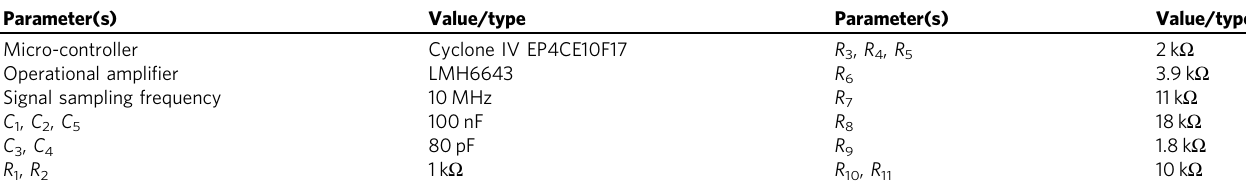
Table 4 Experimental parameters of the receiver and light receiver in the LED lighting